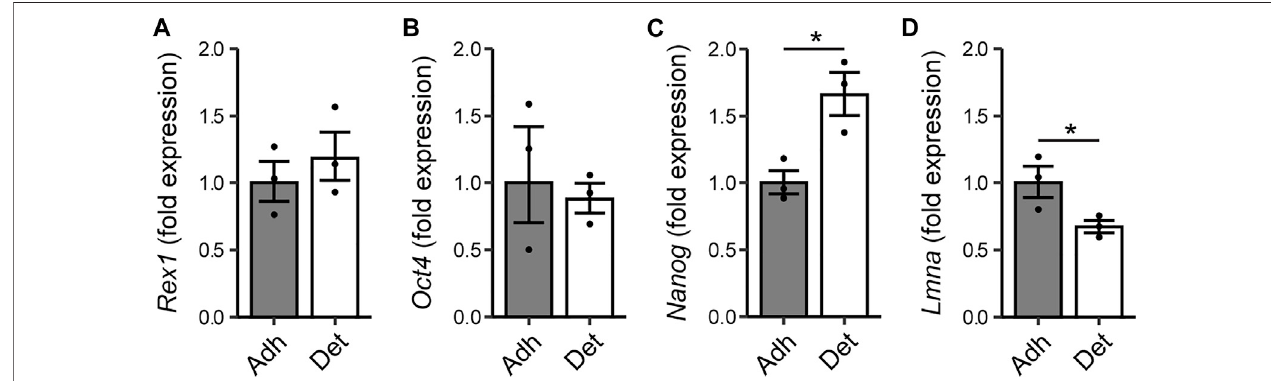
FIGURE 6 | Relationship between adhesion of cells and expression of pluripotency markers. Rex1-GFPd2 cells, cultured in LIF/FBS medium, were subjected to fl uid shear 24 h after cell seeding, causing a proportion of the cells to become mechanically detached from the substrate. RNA was extracted separately from detached cells and the remaining adherentcells. Quantitative PCRrevealsno difference in expression of Rex1 or Oct4 (A,B) , but the readily detached cells have higher expression of Nanog (C) , and reduced expression of lamin A (D) . Fold expression is calculated relative to the adherent cell condition. Mean ± s.e.m. with individual values overlaid. n = 3, Two-sample t -test on ΔΔ Ct values, * p <